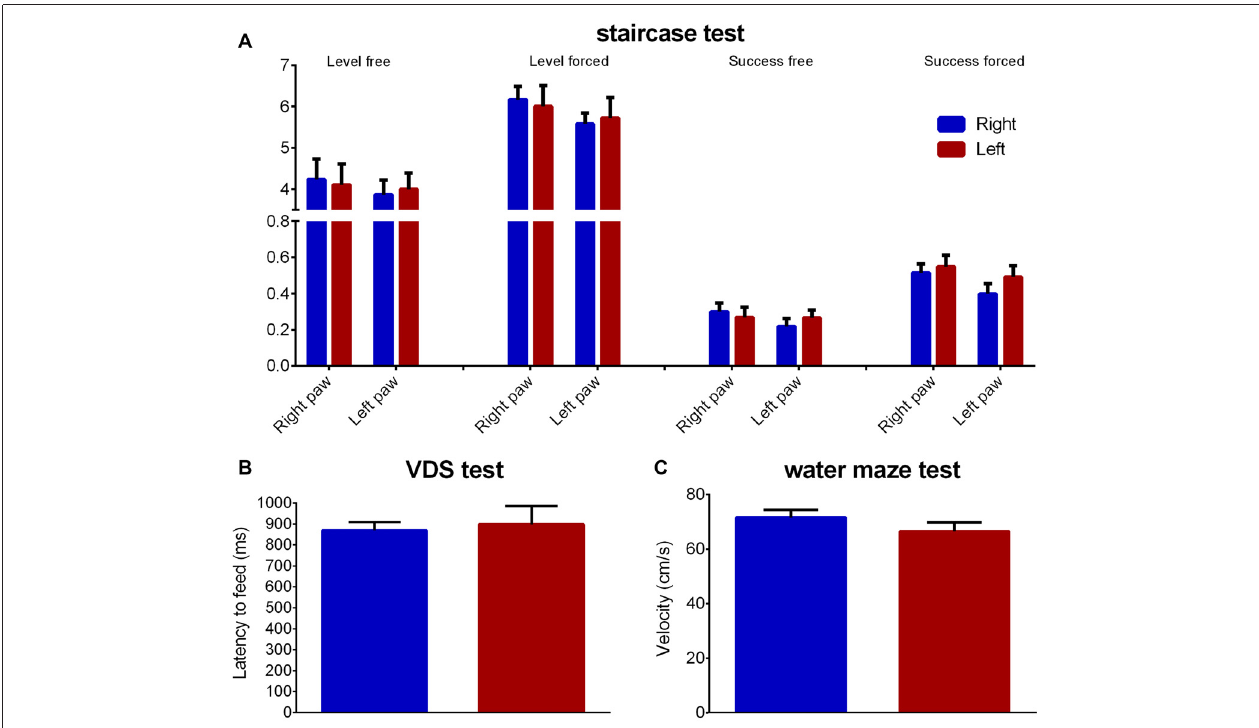
FIGURE 6 | Fine motor and locomotor performance. Group comparison regarding fine motor coordination ( A —staircase test), motivation to eat ( B —latency to feed in the VDS test) and motor performance ( C —velocity in the water maze). Data is shown as mean ± SEM. VDS, Variable Delay-to-Signal; Blue—animals with right paw preference; Red—animals with left paw